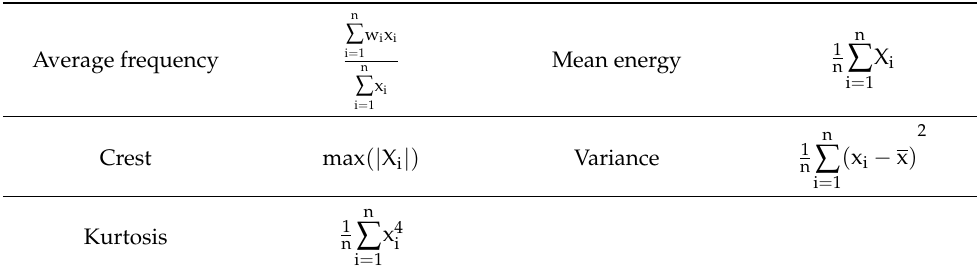
Table 4. Features selected in the frequency domain.